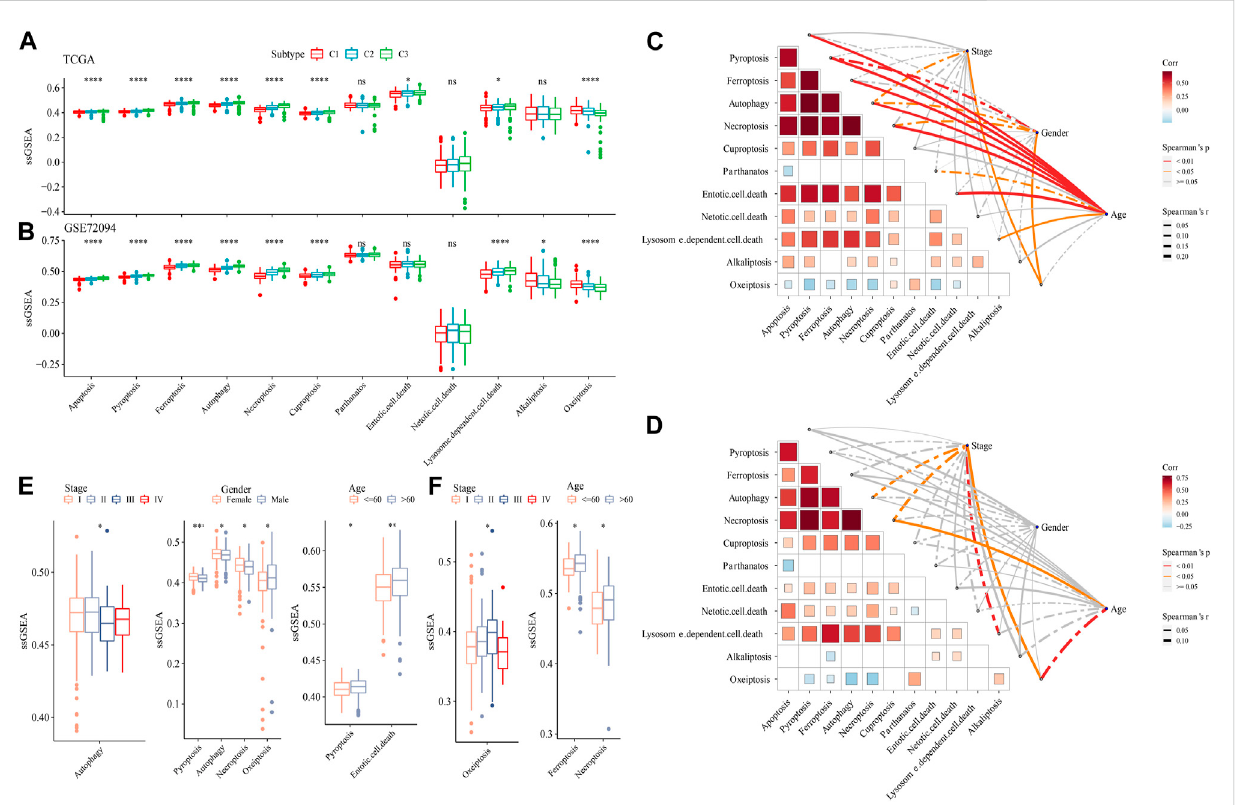
FIGURE 6 The PCD characteristic among 3 molecular subtypes. (A) the ssGSEA analysis of 12 PCD patterns among 3 molecular subtypes in TCGA-LUAD dataset. (B) the ssGSEA analysis of 12 PCD patterns among three molecular subtypes in GSE72094 dataset. (C) The spearman analysis between clinical feature and PCD in TCGA-LUAD dataset. (D) The spearman analysis between clinical feature and PCD in GSE72094 dataset. (E) The ssGSEA analysis of PCD in TCGA-LUAD samples with Stage, Gender and Age. (F) The ssGSEA analysis of PCD in GSE72094 samples with Stage, and